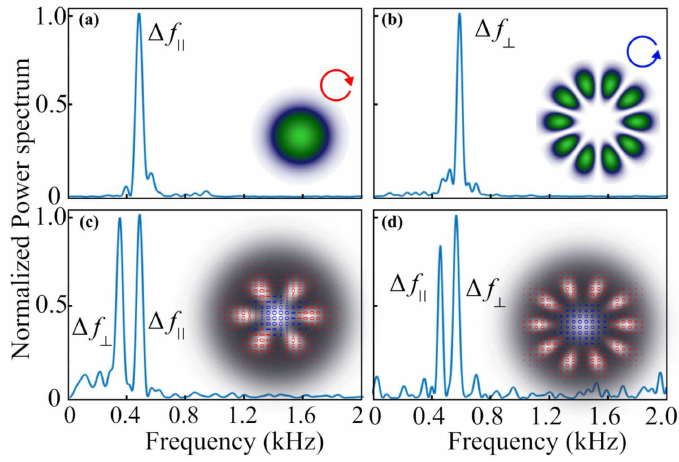
Figure 12. The beat spectrum when using different beams for illumination. ( a ) Pure translation under Gaussian illumination, ( b ) pure rotation under structured light illumination. Composed motion under vector beam illumination for ( c ) l = ± 3 and ( d ) l = ± 5. Adapted with permission from ref.